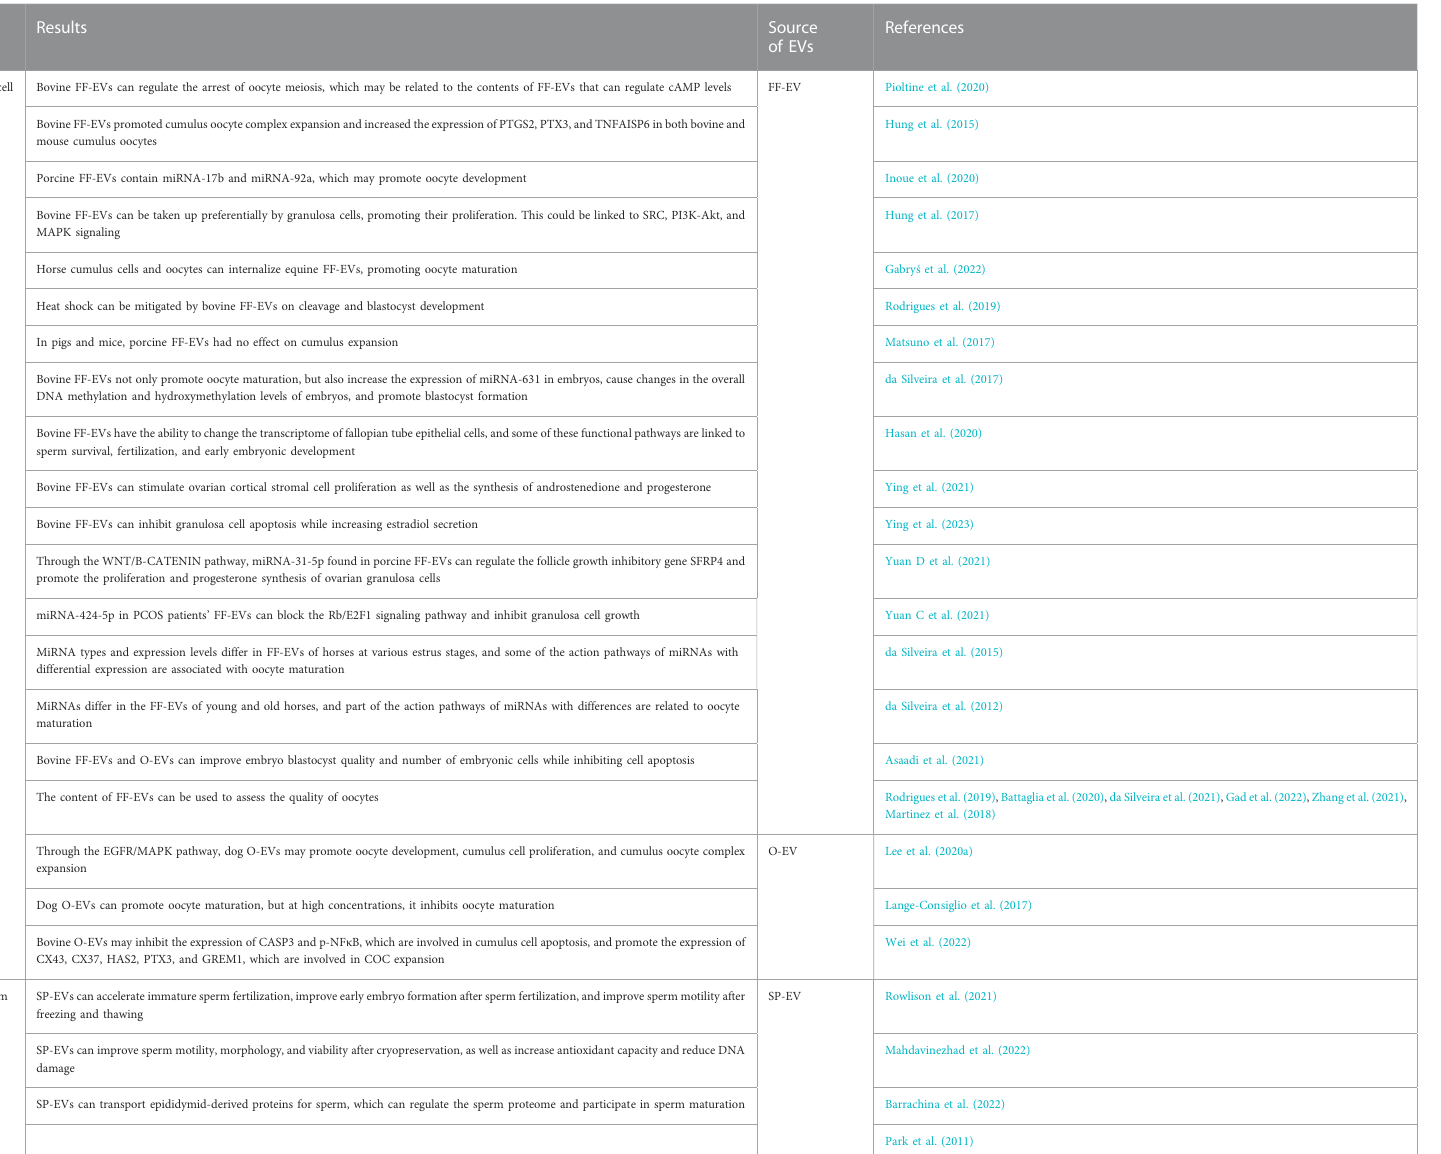
TABLE 1 EV ’ s potential role as a messenger in the human uterus during gametophyte fertilization, early embryonic development, and